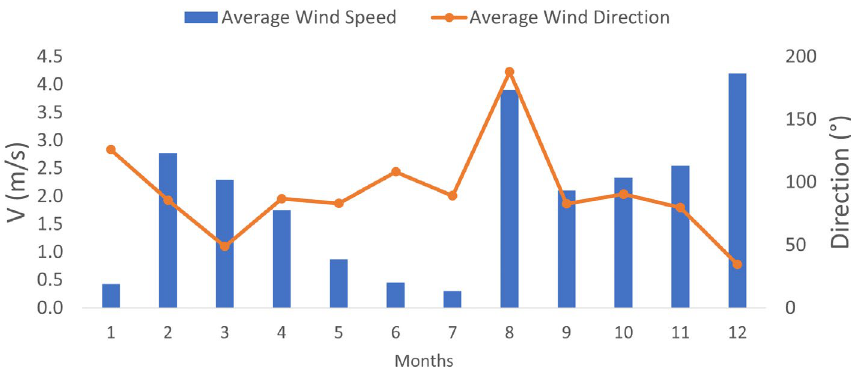
Figure 4. Average wind speed and direction for each month of the year.